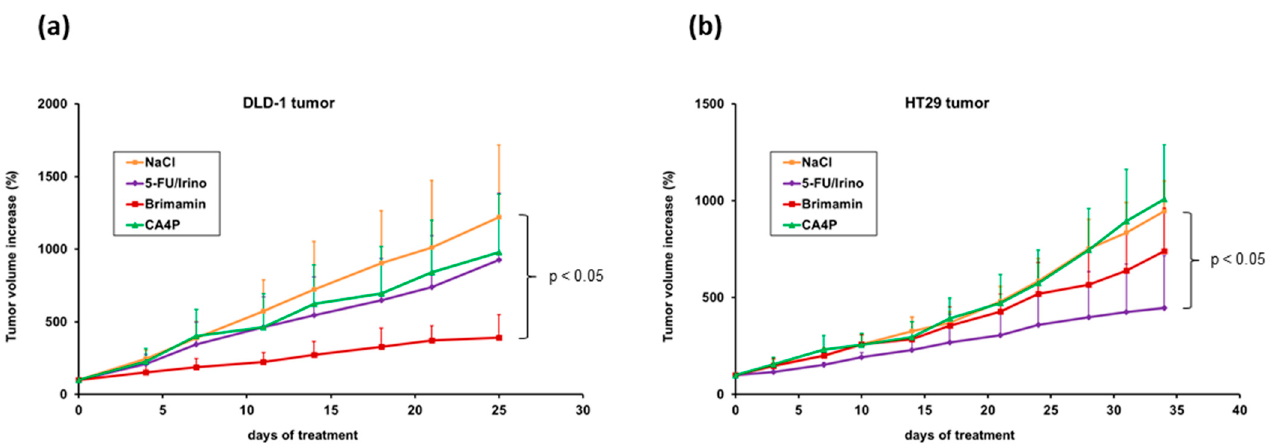
Figure 4. Antitumor activity of brimamin compared with CA-4P and standard treatment. Nude mice bearing s.c. xenograft tumors of DLD-1 ( a ) and HT29 ( b ) were treated with NaCl (control), brimamin (25 mg/kg BW), CA-4P (250 mg/kg BW), or 5-FU + irinotecan (30 mg/kg + 50 mg/kg BW) on days 0, 7, 14, 21, and 28 (only HT29). The tumor volume increase relative to the start of treatment on day 0 is shown, as mean values ± SD ( n = 6).